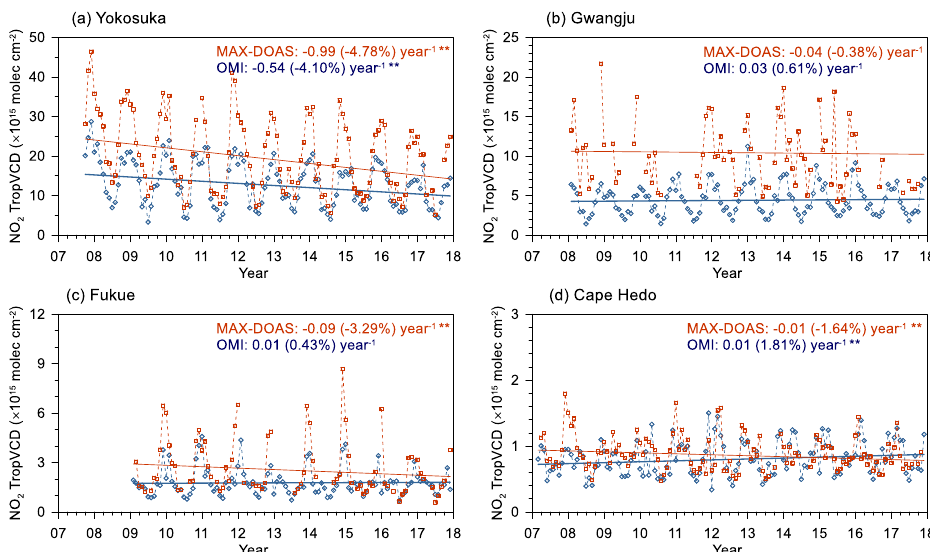
Figure 3. Long-term variations in the monthly mean of time-matched NO 2 TropVCD from 2007 to 2017 at four sites. Red and blue symbols with solid lines denote the Theil-Sen slope for the MAX-DOAS and OMI satellite, respectively. The slopes and percent changes are shown in the upper right corner along with the p -value: ** p < 0.01, * p < 0.05, + p < 0.1.